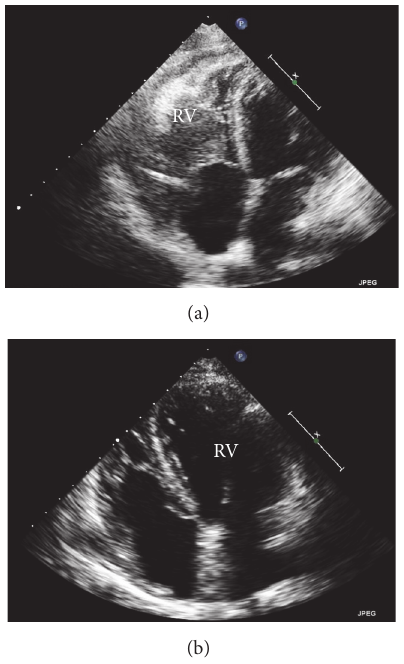
Figure 2: Pre- and posttransthoracic echocardiogram images. (a) Apical four-chamber view demonstrating a large mass in the right ventricle with extension into the right atrium. (b) Apical four- chamber view demonstrating complete resolution of the mass after chemotherapy.